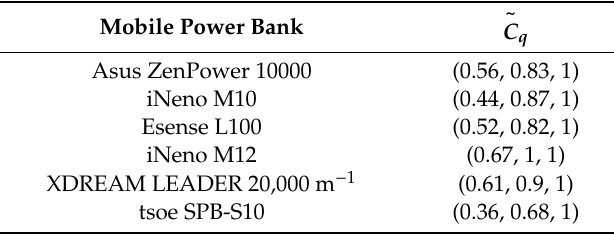
Table 8. Fuzzy closeness of each mobile power bank.